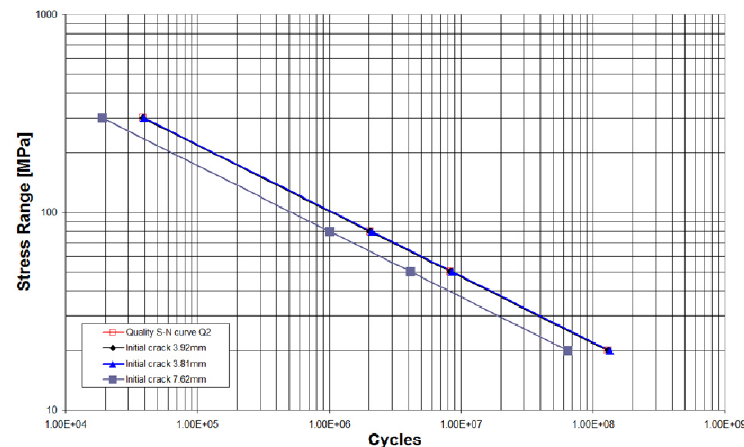
Figure 7: Life at different crack sizes and stress ranges.